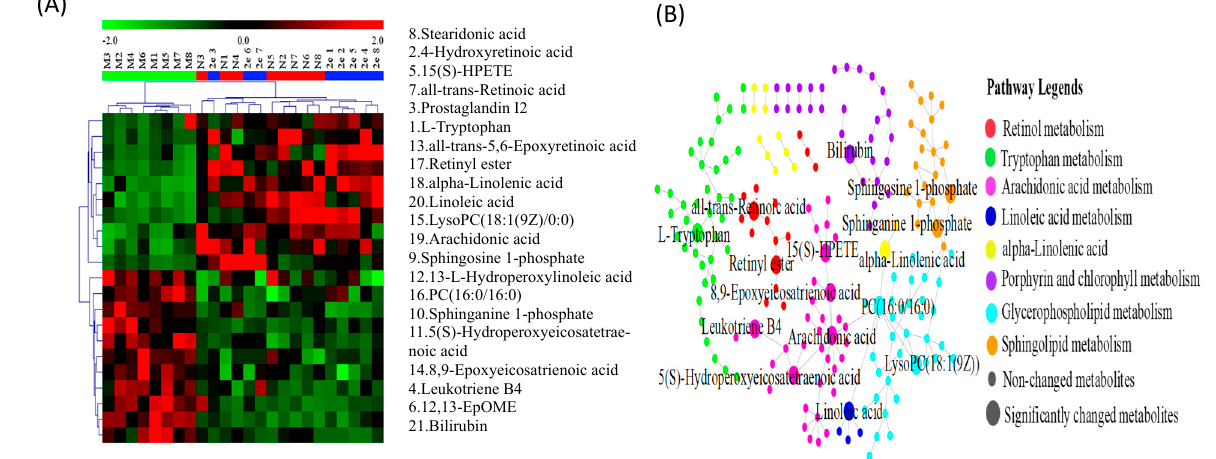
Figure 9. The heatmap ( A ) and the metabolic pathways ( B ) of all potential biomarkers.